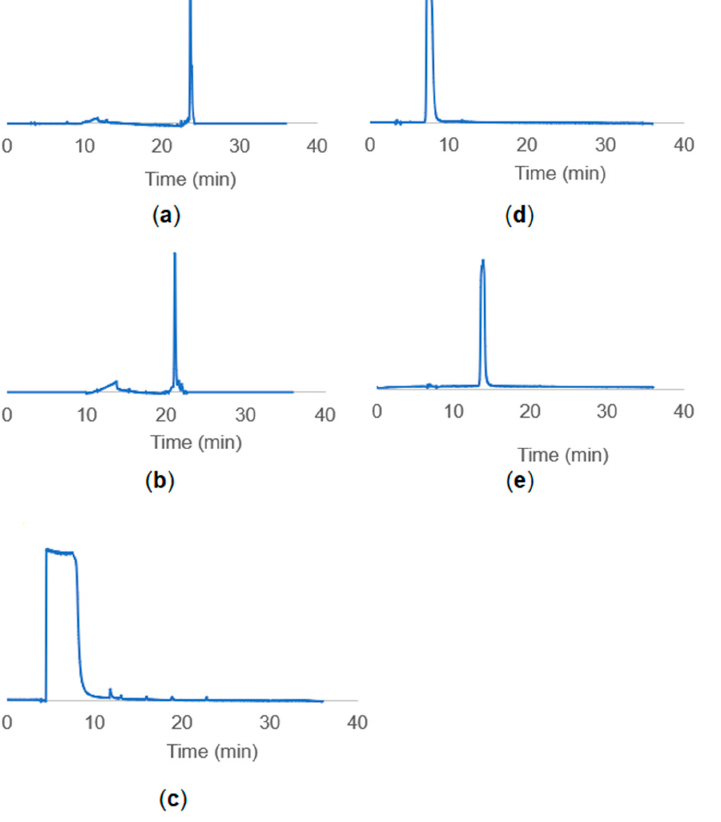
Figure 3. HPLC results of ( a ) pure TBT1 peptide, ( b ) pure TBT2 peptide and ( c ) MAL ‐ PEG 8 ‐ NHS linker molecules and HPLC results of the ( d ) TBT1 conjugates and ( e ) TBT2 conjugates collected after Sephadex ‐ G25 column purification. Scanning was performed for 30 min between 5–80% B gradient at a flow rate of 0.4 mL/min. Also, TBT1 and TBT2 peptides were analyzed with LC ‐ MS/MS for their chemical